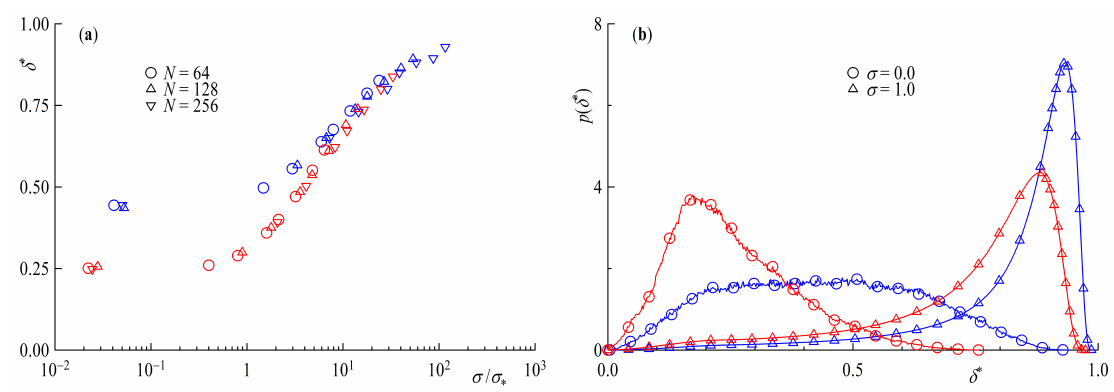
Figure 8. ( a ) Asphericity δ ∗ as a function of the surface overlap concentration σ / σ ∗ and ( b ) asphericity frequency distribution F ( δ ∗ ) for N R = 128 and N L = 64. Red symbols are rings and blue for tails.